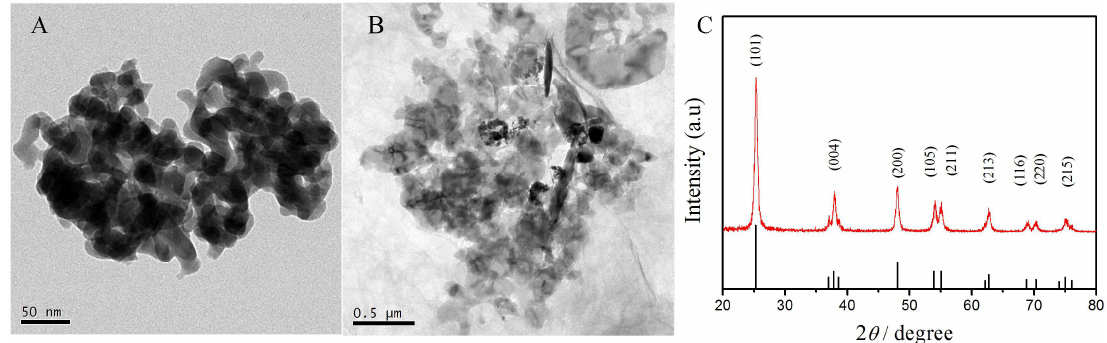
Figure 1. The TEM images of TiO 2 ( A ) and TiO 2 –graphene oxide (GO) ( B ); The XRD pattern of TiO 2 nanoparticles (NPs) ( C ).